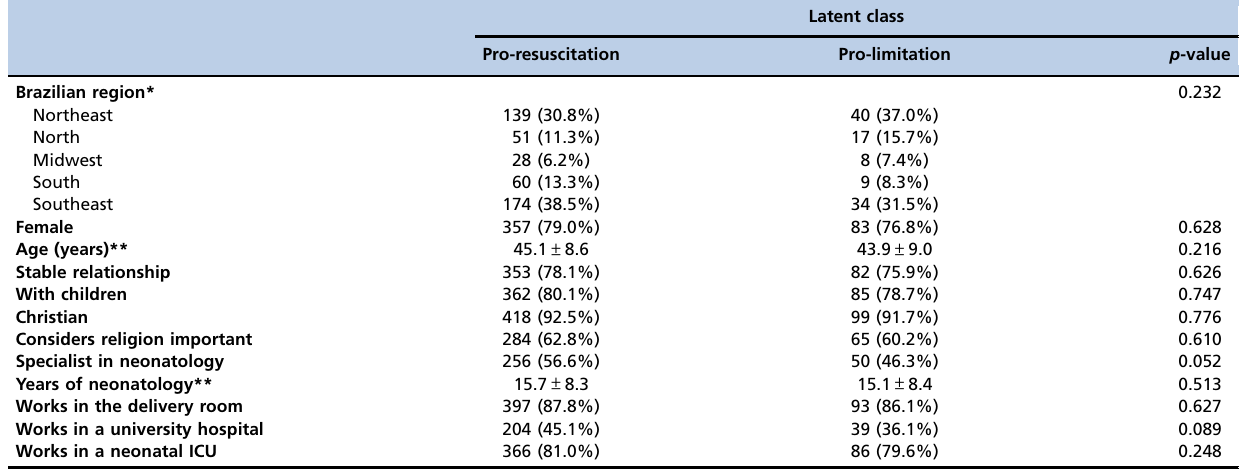
Latent class Pro-resuscitation